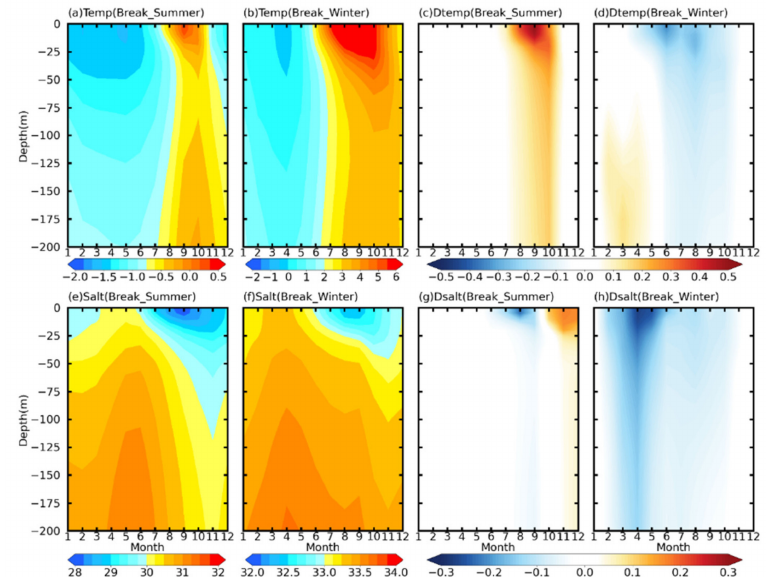
Figure 10. ( a , b ) indicates the temperature profile in the upper 200 m averaged over the Break_Summer and Break_Winter in the Ctrl experiment, respectively. ( c , d ) indicates the differences in tempera- ture profile between Break and Ctrl in the upper 200 m averaged over the Break_Summer and Break_Winter, respectively. ( e – h ) Same as ( a – d ), but for